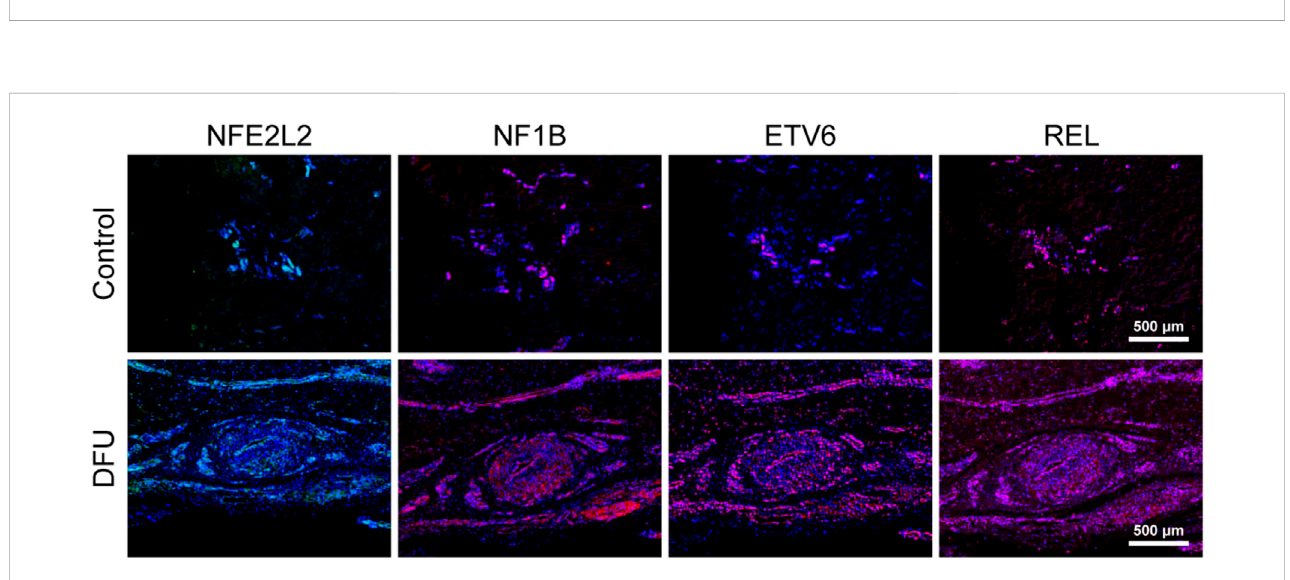
FIGURE 7 Immune-associated genes are associated with the relative immune microenvironment for